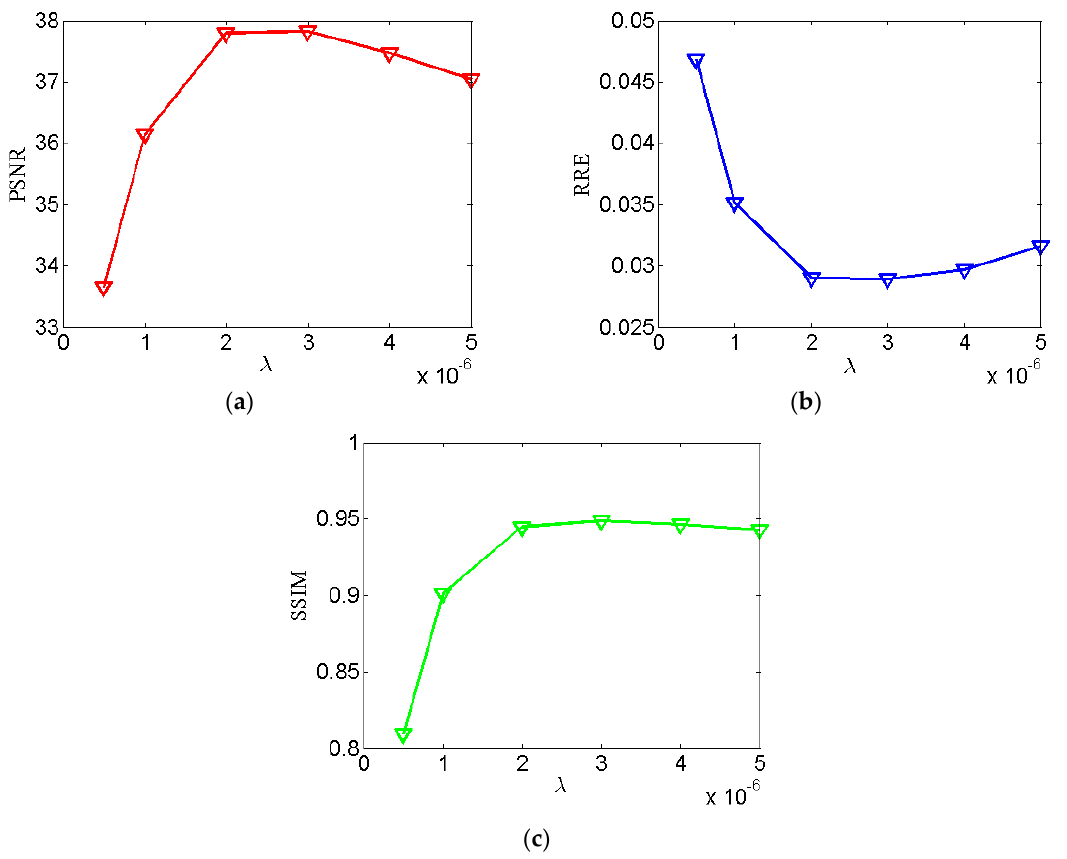
Figure 7. Image quality assessments of reconstructed Thorax phantom images for the SIR-STV 1 method with respect to different λ . ( a ) The PSNR curve; ( b ) The RRE curve; ( c ) The SSIM